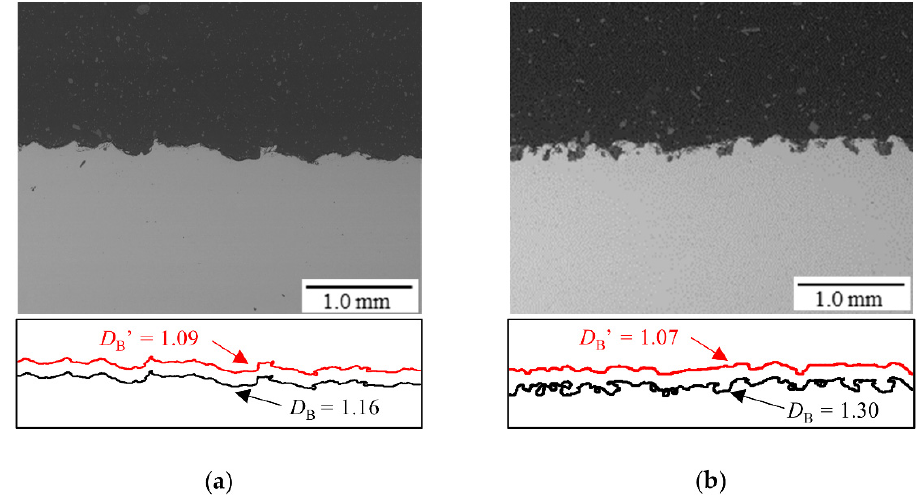
Figure 4. Fractal dimension ( D B ) analysis of roughness from the SEM images of the cross-section of the blasted specimens: ( a ) MST, ( b ) MAL.